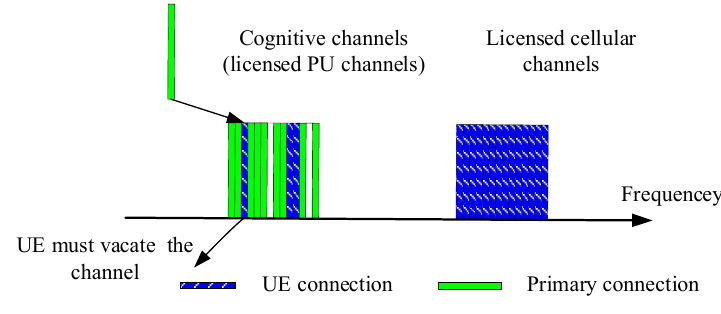
Fig. 1. System architecture of the OSA-based